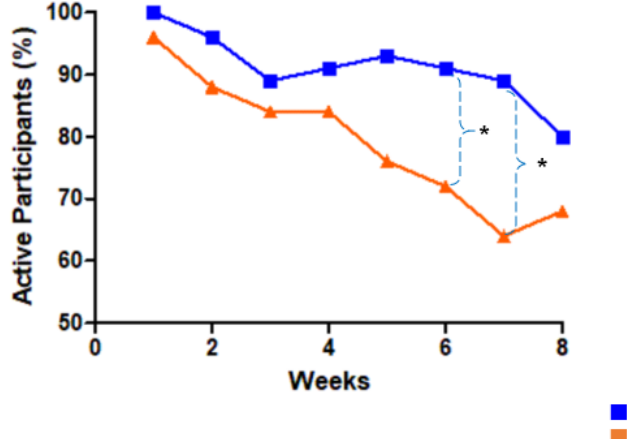
Figure 7. Patterns of changes in engagement rate of the experimental and control groups during the intervention period. * P <.05.